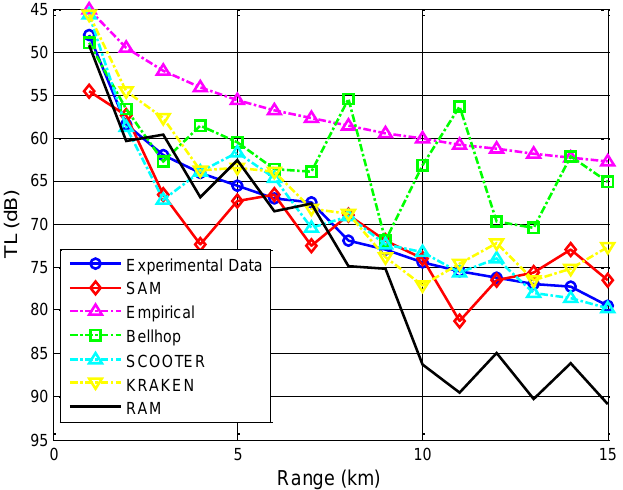
Figure 9. Transmission loss vs . range under different models in an Australian ocean